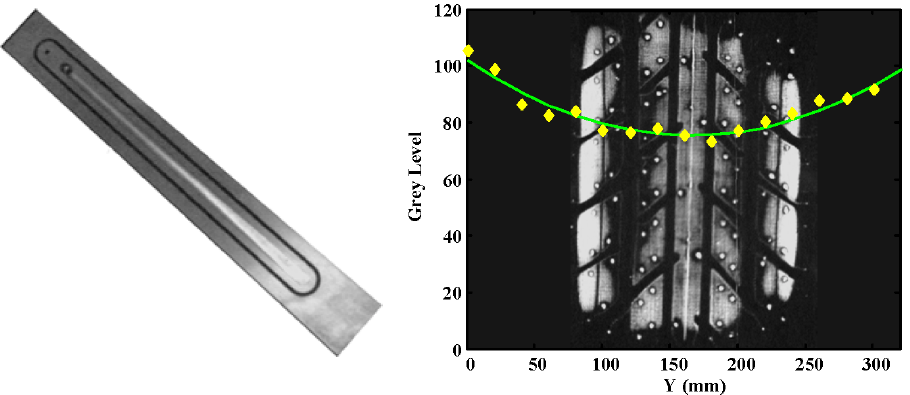
Figure 12. Calibration part ( left ); and transverse absorption of light vs. distance in the glass of the test bench ( right ).